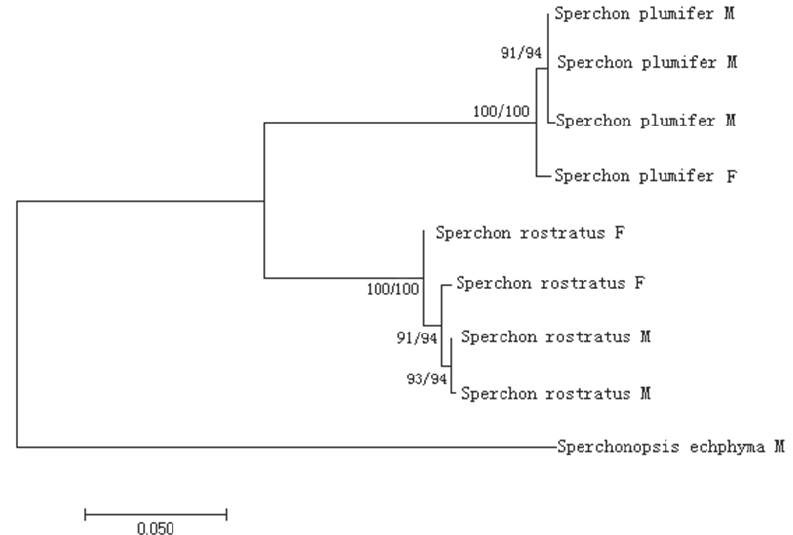
Figure 20. Phylogenetic tree based on barcode region of COI of Sperchon plumifer , Sperchon rostratus, and Sperchonopsis echphyma . The bootstrap proportions of neighbour-joining and maximum-likelihood are indicated above each branch in the format of NJ/ML. Sperchonopsis echphyma was used as the